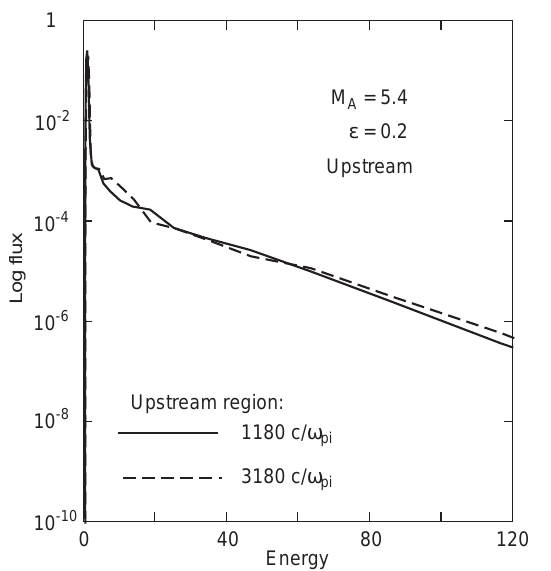
Fig. 6. Dependence of the upstream flux distribution at X cp t (cid:136) 600 on Alfve´ n Mach number M A . Shown are results from 3 cases: M A (cid:136) 4 : 1 ; 5 : 4,